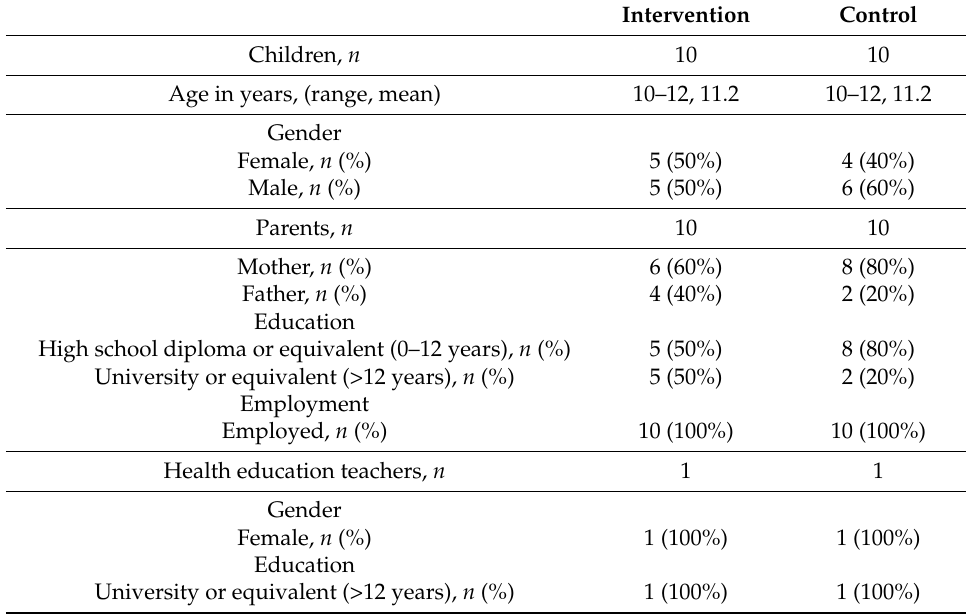
Table 1. Participants’ and providers’ characteristics by group.